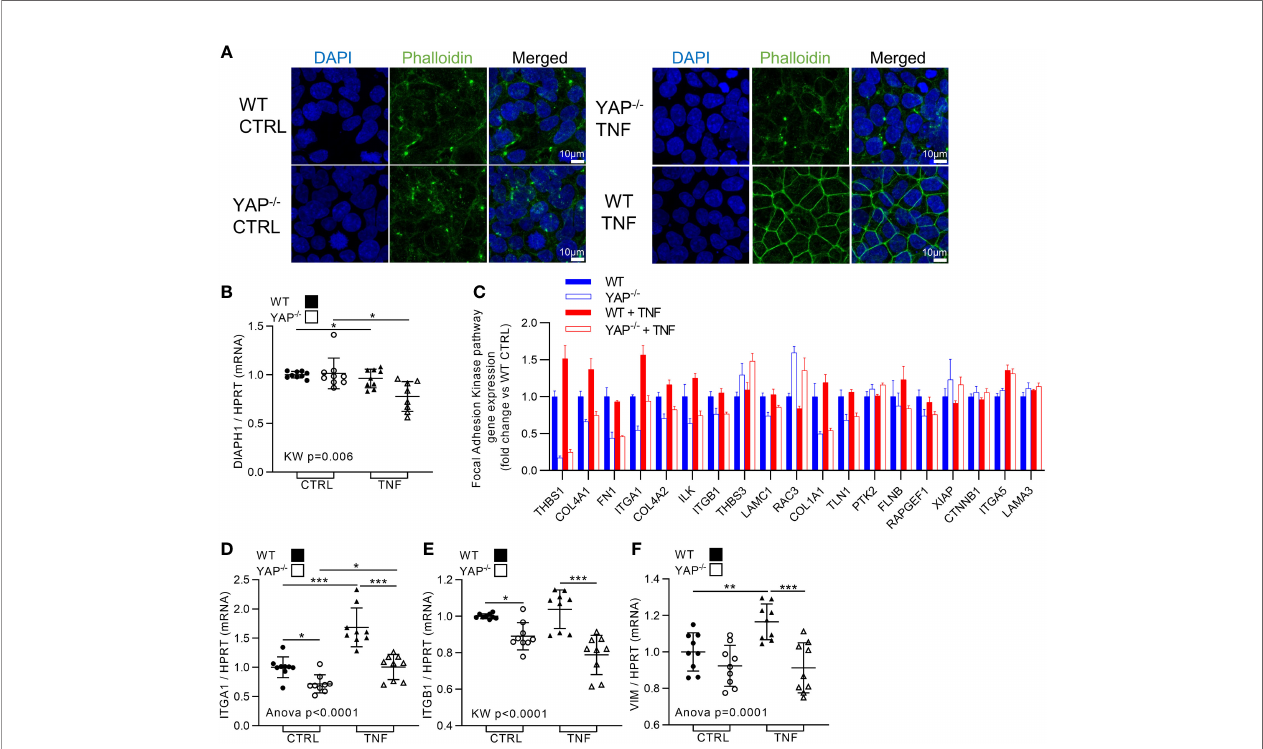
FIGURE 7 | YAP drives TNF effect on cytoskeleton re-organization and focal adhesion kinase pathway. HEK293 cells were cultured and treated with TNF as described in Figure 1 . (A) Representative airyscan confocal z-stack max intensity images of phalloidin (actin, green) and DAPI (nucleus, blue), and merged images (luminosity and contrast were enhanced identically for each image for clarity purpose). (B) RT-qPCR quanti fi cation of DIAPH1 expression normalized to HPRT expression. (C) Nanostring fi brosis panel histogram for focal adhesion kinase pathway in the four groups; depicted genes were selected if at least one comparison between 2 groups gives a p-value <0.05 and must be related to focal adhesion kinase signaling. (D, E) RT-qPCR quanti fi cation of ITGA1, ITGB1, and VIM expression normalized to HPRT expression. Confocal images are representative of three independent experiments. For RT-qPCR, results are representative of three independent experiments with 3 biological replicates for each experiment (n = 9 per group) with T-test or one-way ANOVA test and FDR corrected for multiple comparisons post hoc tests was performed between conditions: *p < 0.05; **p < 0.01; ***p < 0.001. Data are expressed as fold change vs. control and presented as individual values with mean ± SD (B, D – F) or presented as histogram with mean + SD (C)